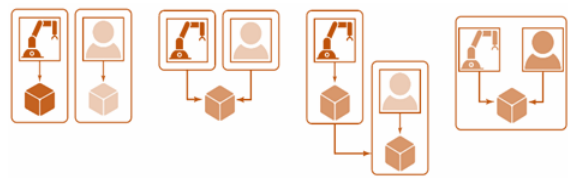
Figure 1 Different levels of HRC (adapted for